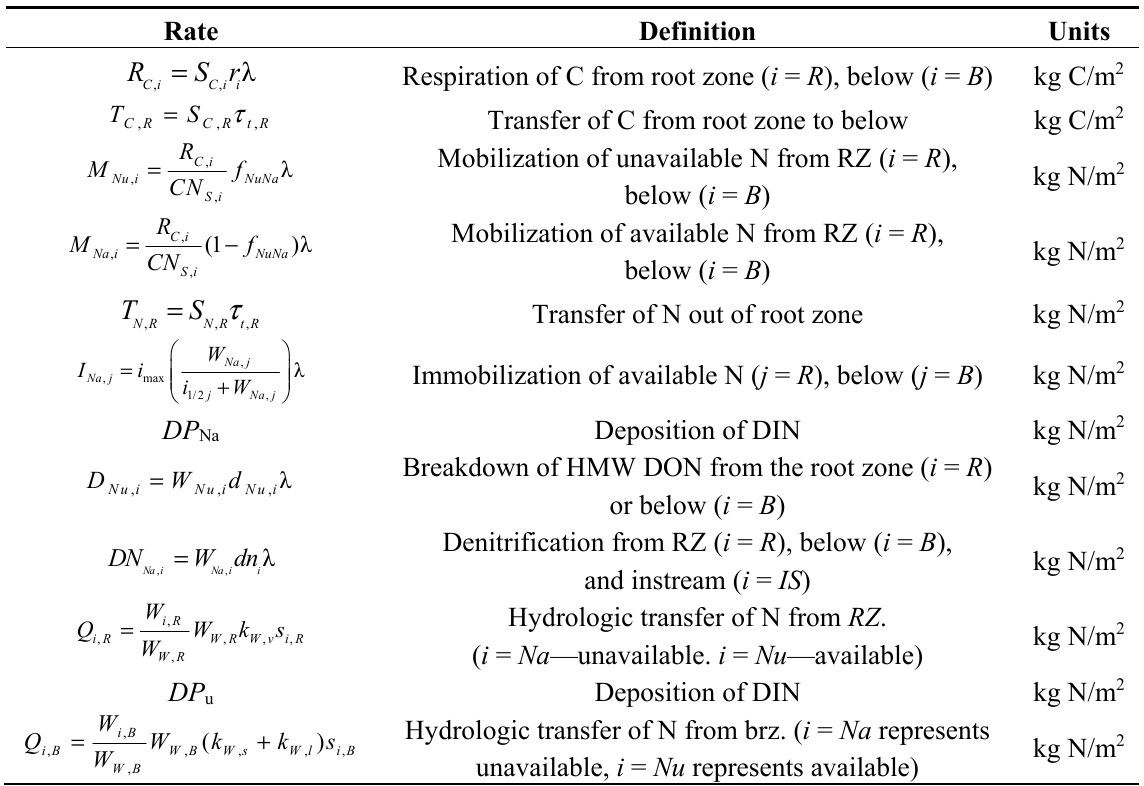
Table 5. Rate terms comprising soil-processing mass balance equations. See Table 7 for parameter